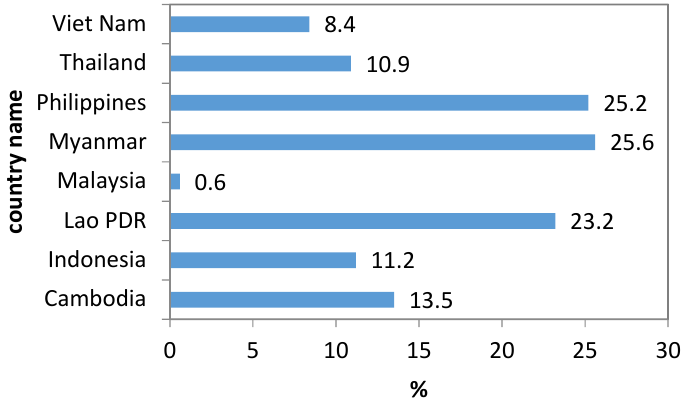
Figure 2. Percentage of population below the national poverty line in Vietnam and other Asian countries in 2014. Source: ADB data from 2014 [10].